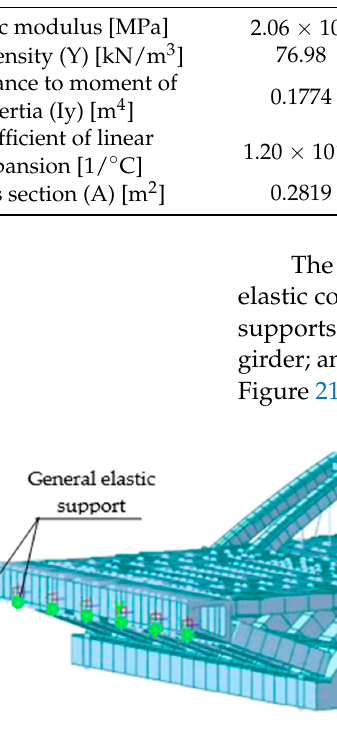
Figure 21. Rigid connections and elastic connections in the FE model.